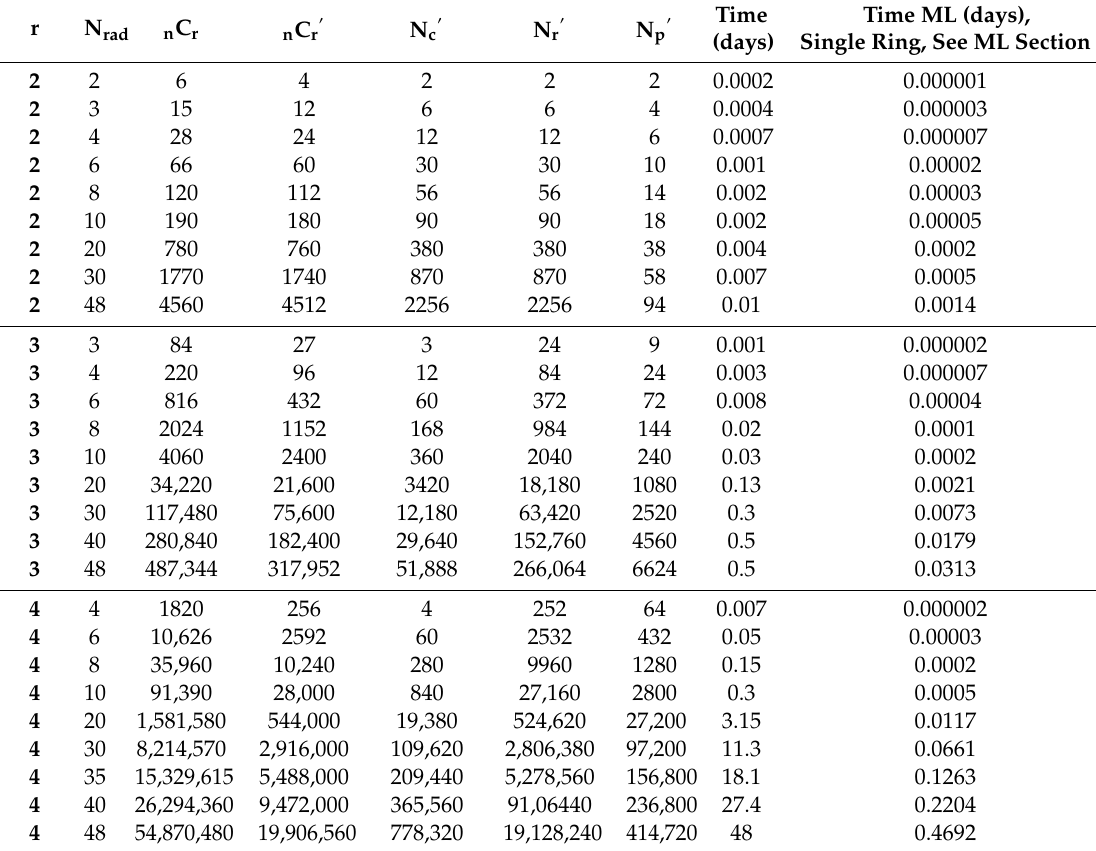
Table 1. Di ff erent configurations for the proposed 48 × 4 commercial design. n C r and n C r builds and combinations are given. The number of combinations r corresponds to the number of rings, N ring . Each radius has a di ff erent drug and each ring a di ff erent dilution. The e ff ect of dilution can be observed in this table. The e ff ect of machine learning can also be seen by comparing the time taken for the droplets when dilutions are considered to the time taken with machine learning. All configurations are for the same